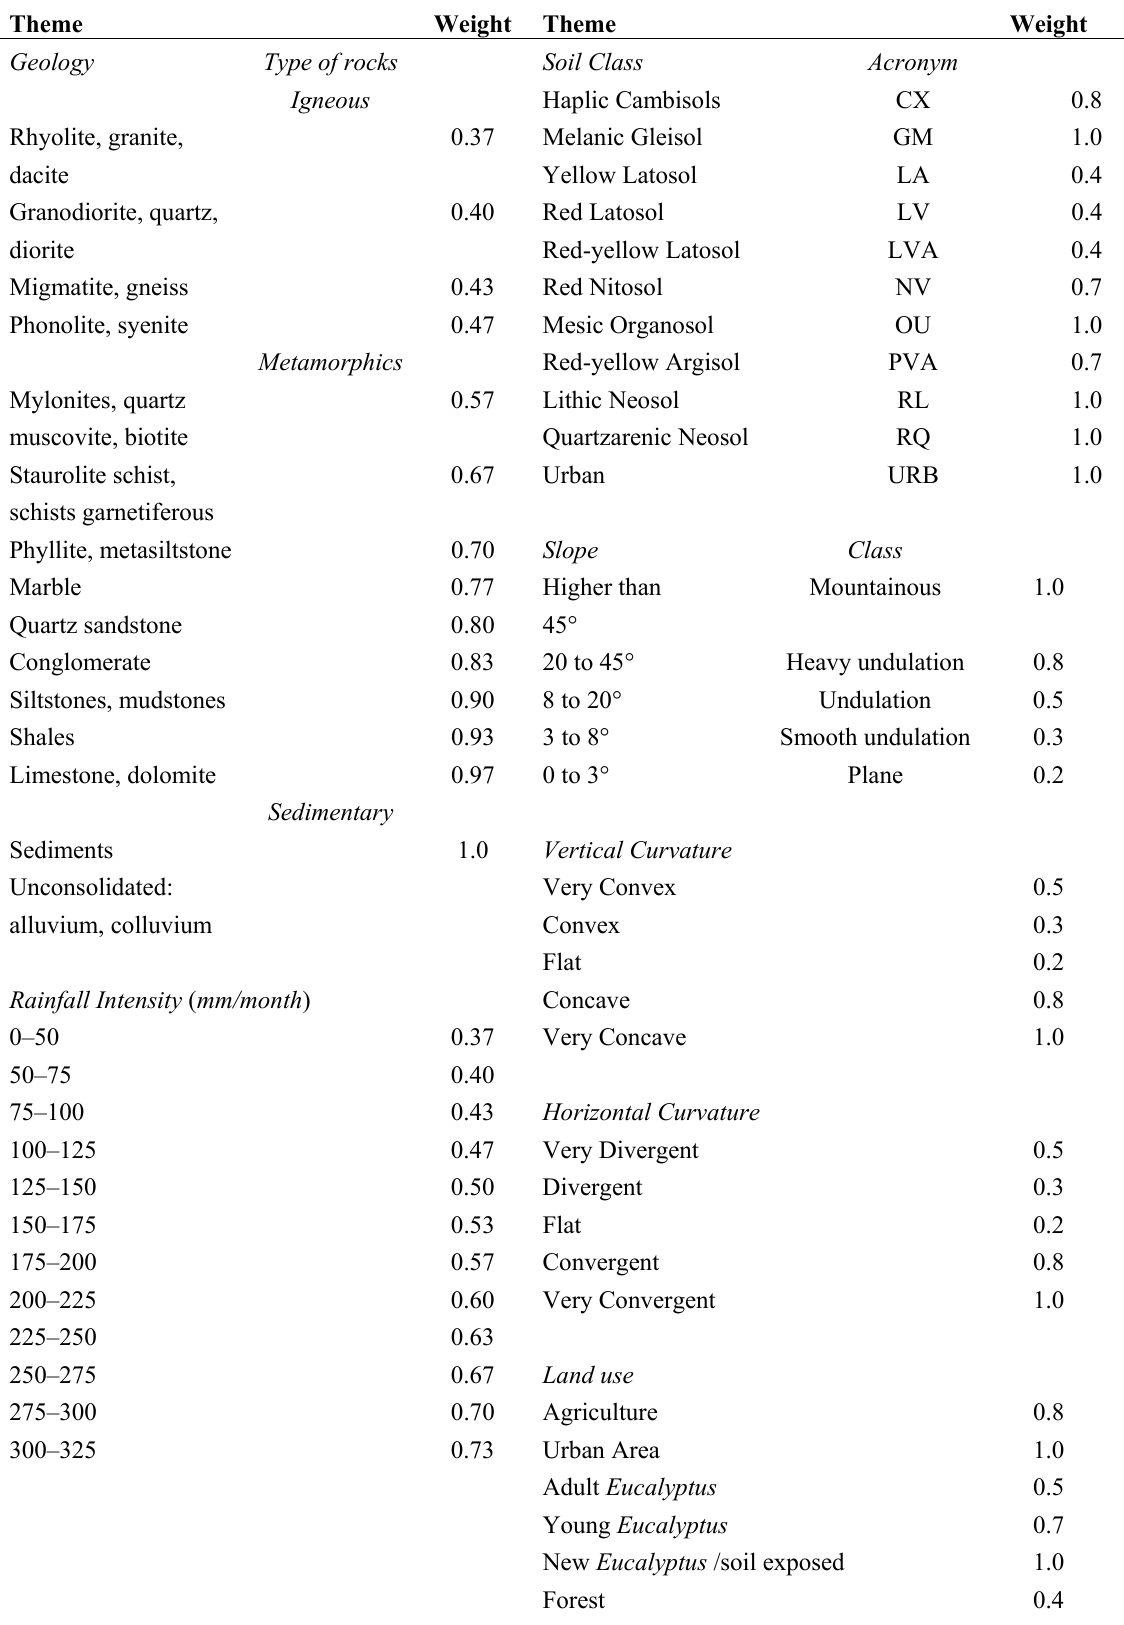
Table 3. Collected data and their weights in relation to landslide